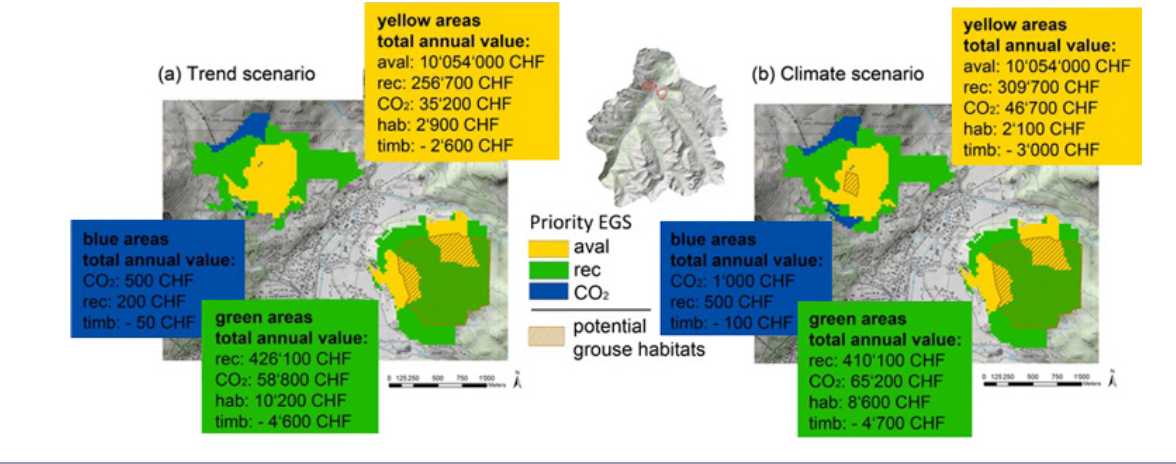
Fig. 5 . Illustrative example of selected ecosystem services bundles in the tourism dominated region Davos under a trend and a climate change scenario. The figure shows a simulated spatial pattern of summed values of avalanche protection (aval), recreation (rec), carbon sequestration (CO2), habitat provision (hab), and timber production (timb) for two different forest areas. Priority ecosystem services exhibit the highest value in specific forest plots. Areas with avalanche protection as priority ecosystem service in yellow provide also recreation, C-sequestration, habitat services, and timber as ecosystem goods and services (EGS) of varying values. Areas with recreation as priority ecosystem service in green provide also C- sequestration, habitat services and timber. Areas with C-sequestration as priority ecosystem service in blue provide also recreation and timber. Bundles of EGS are very similar in both scenarios (adapted from Grêt- Regamey 2012 a